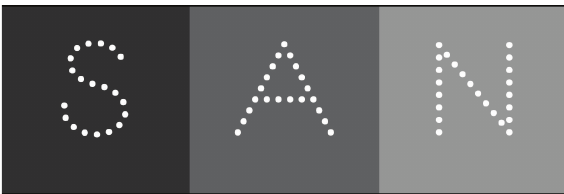
Figure 1: An example of the algorithmically generated letter triplet for testing VA. VA: visual acuity.